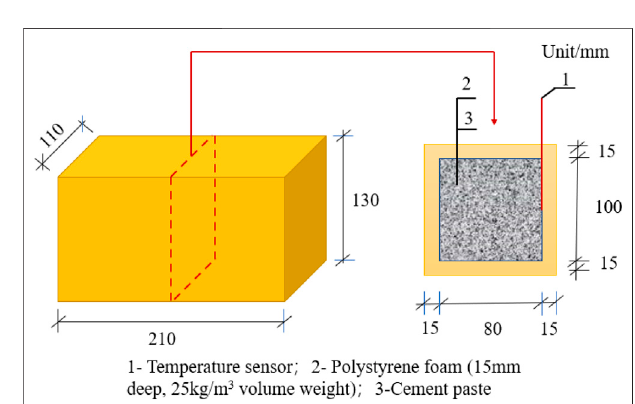
FIGURE 1 | XRD patterns of single